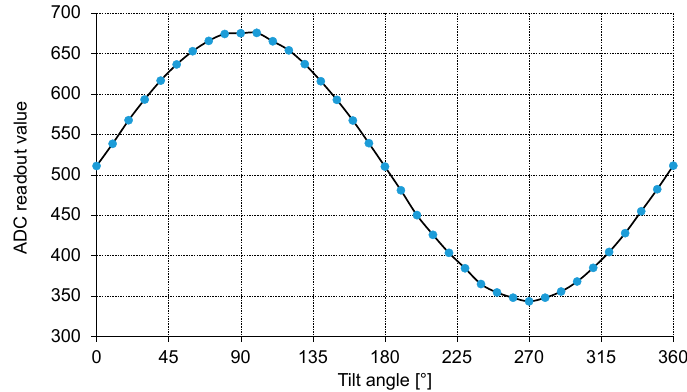
Figure 16. The output of the ROIC as a function of the tilt angle.